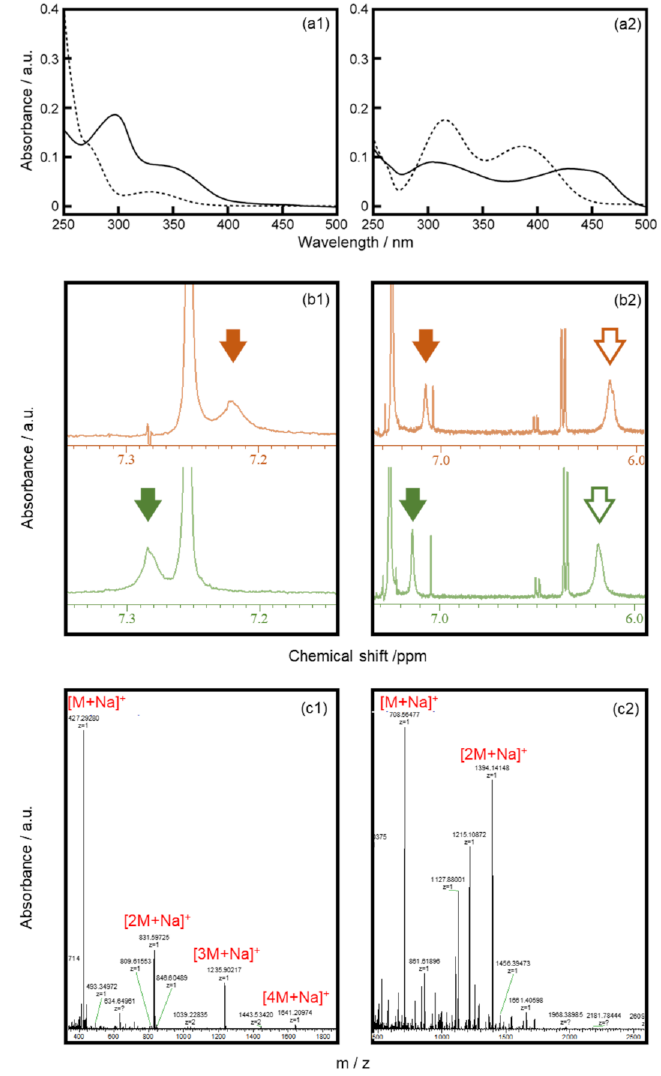
Figure 5. ( a1 , a2 ) UV-Vis spectra for the 12 µ M chloroform solution (dotted lines) and solid film (solid lines) of MANA ( a1 ) and OPANA ( a2 ); ( b1 , b2 ) amide proton chemical shifts in 1 H-NMR spectra at 293 K (green lines) and 323 K (orange lines) of MANA ( b1 ) and OPANA ( b2 ); ( c1 , c2 ) ESI-TOF MS spectra measured in positive mode for MANA ( c1 ) and OPANA ( c2 ). All spectra were obtained from MANA (1) and OPANA